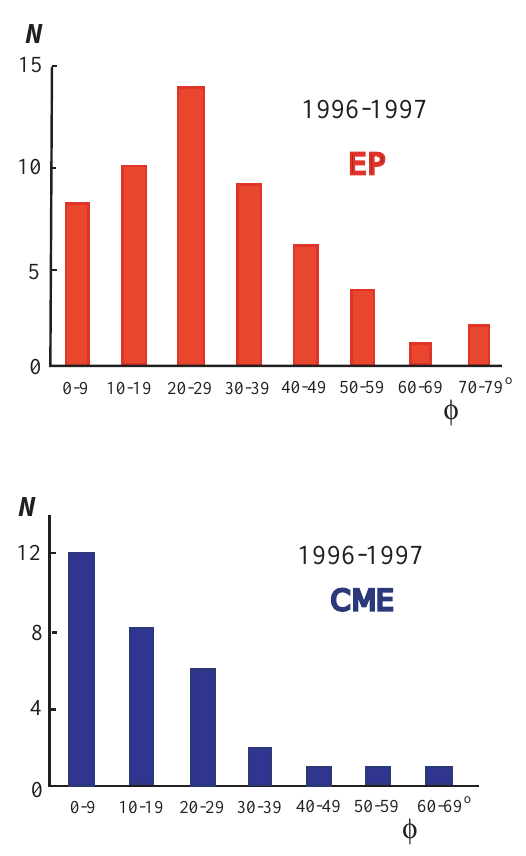
Fig. 3. Angular distribution of eruptive prominences and CMEs about the magnetic equator ( φ =0) for the epoch of solar minimum.